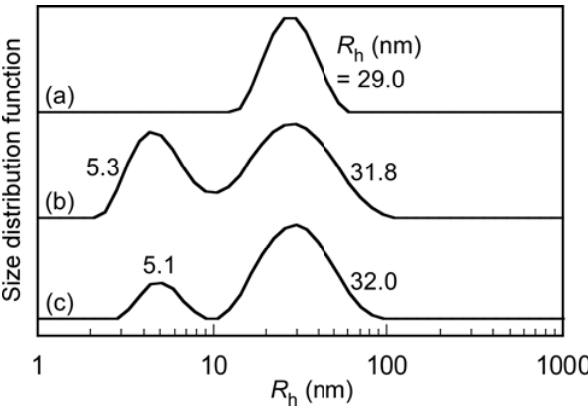
Figure 9. (a) R h distributions for ( a ) PIC micelles, ( b ) FBS, and ( c ) a mixture of PIC micelles with FBS in PBS buffer at 25